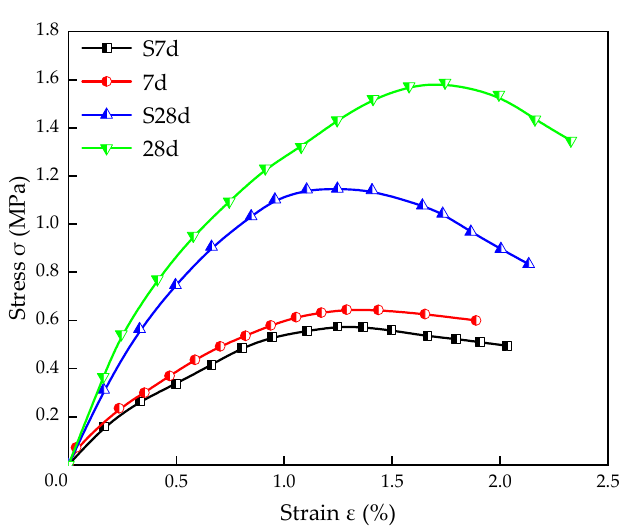
Figure 6. Stress–strain curves of stabilized silt with different curing conditions for 25% TS